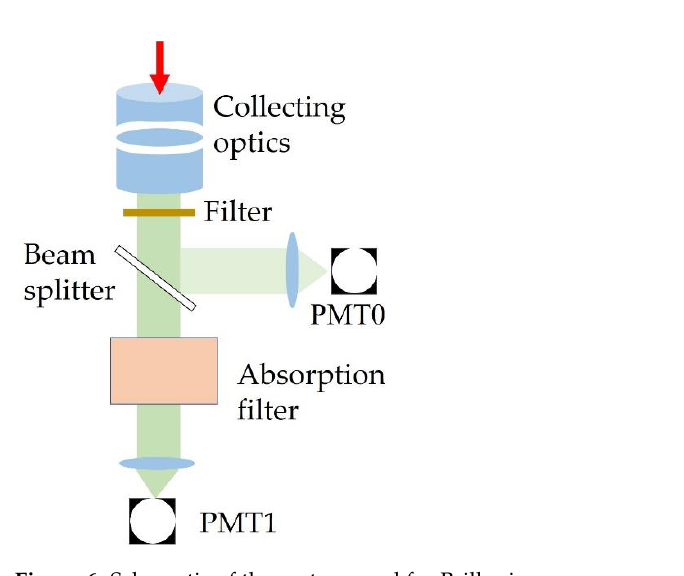
Figure 6. Schematic of the system used for Brillouin energy measurement.